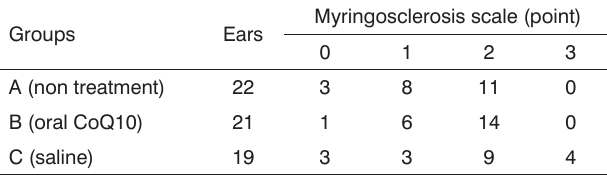
Table 1. Otomicroscopic examination of sclerotic lesions.